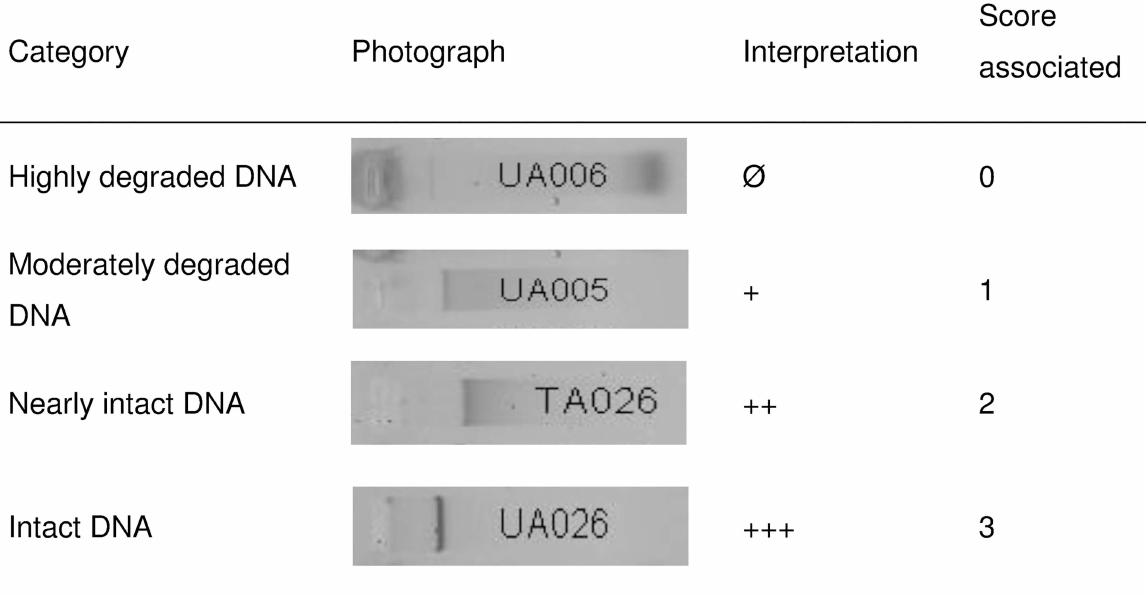
Fig 1. Interpretation of the genomic DNA integrity using agarose gel